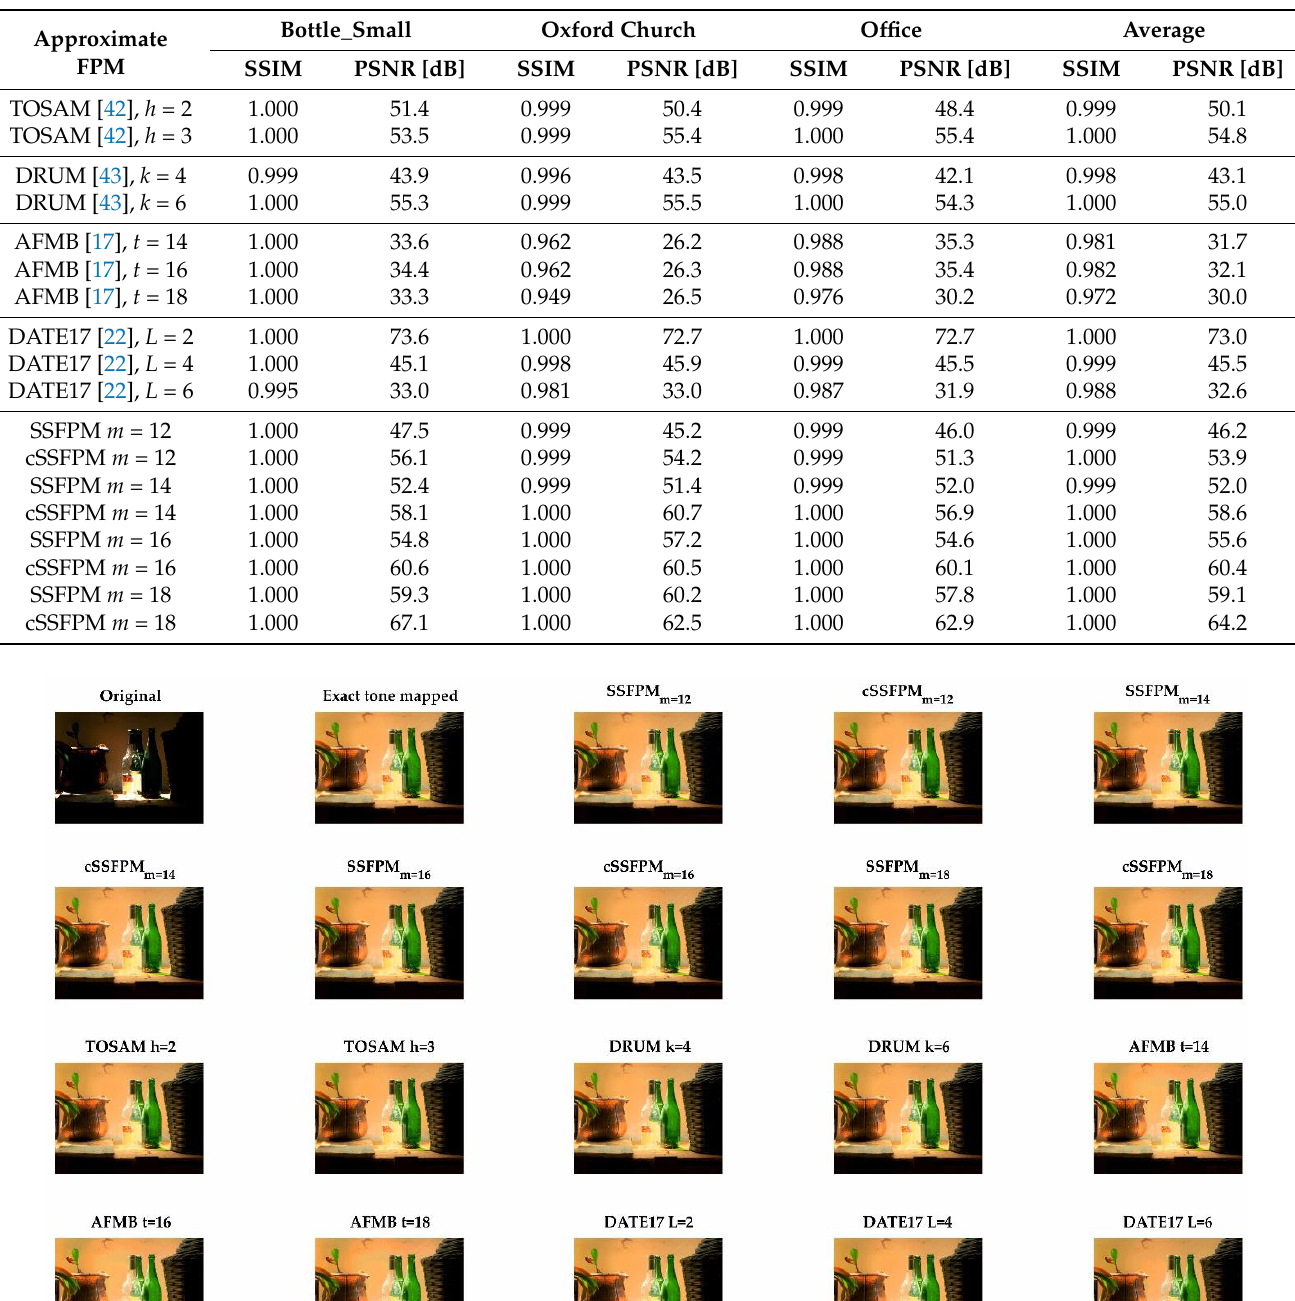
Table 6. Results for tone mapping of HDR images.